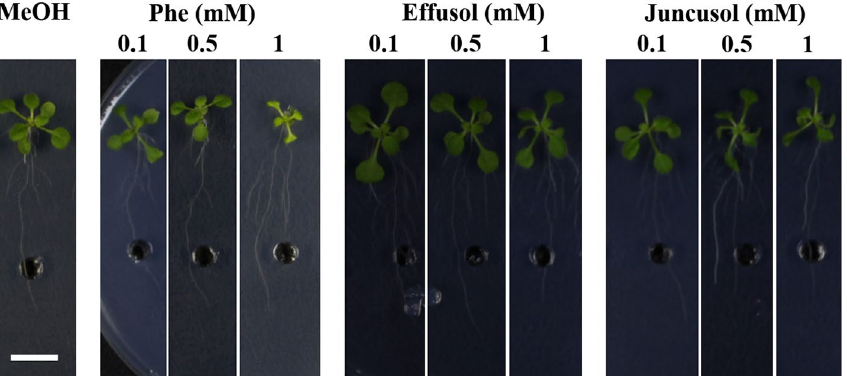
Figure 2. Representative images of Arabidopsis thaliana seedlings treated with phenanthrene (Phe), effusol and juncusol at different concentrations compared to methanol (MeOH). The applied concentrations were 0.1, 0.5 and 1 mM and were supplied via a hole in the agar plate. Scale bar 1 cm.